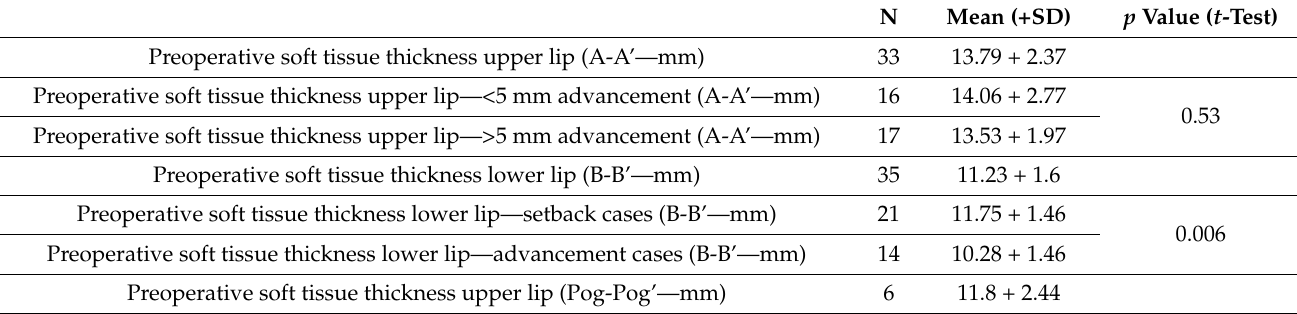
Table 1. Preoperative soft tissue measurements.